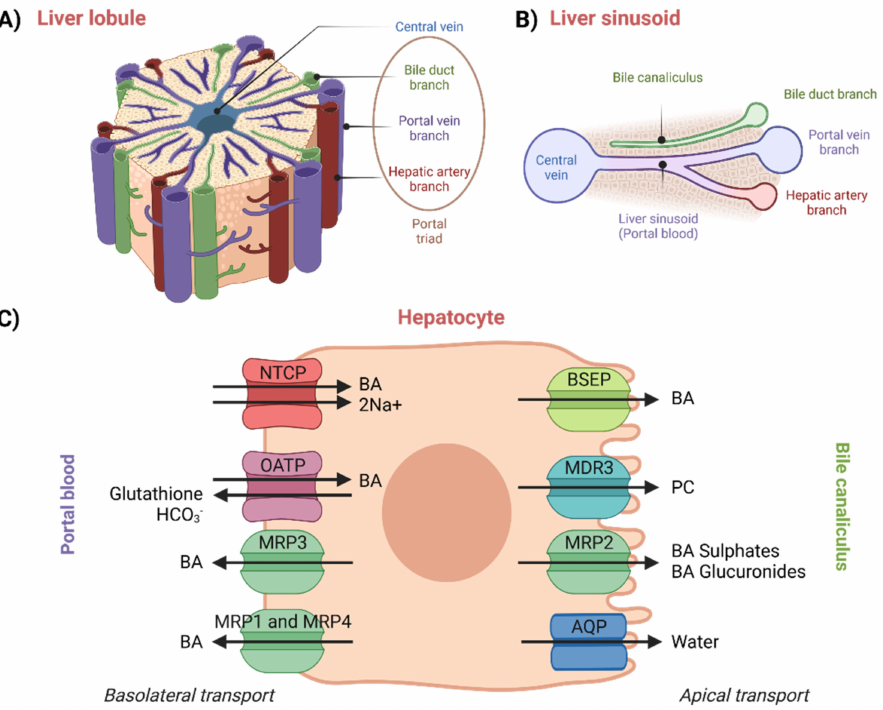
Figure 4. Illustration of: ( A ) liver lobule, ( B ) liver sinusoid, and ( C ) transport proteins and processes described to be taking place in hepatocytes. Created with